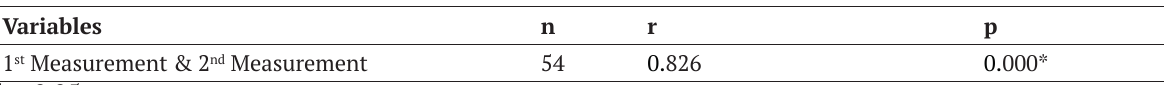
Table 7. Correlation analysis between measurement values of the control group (Paired Samples